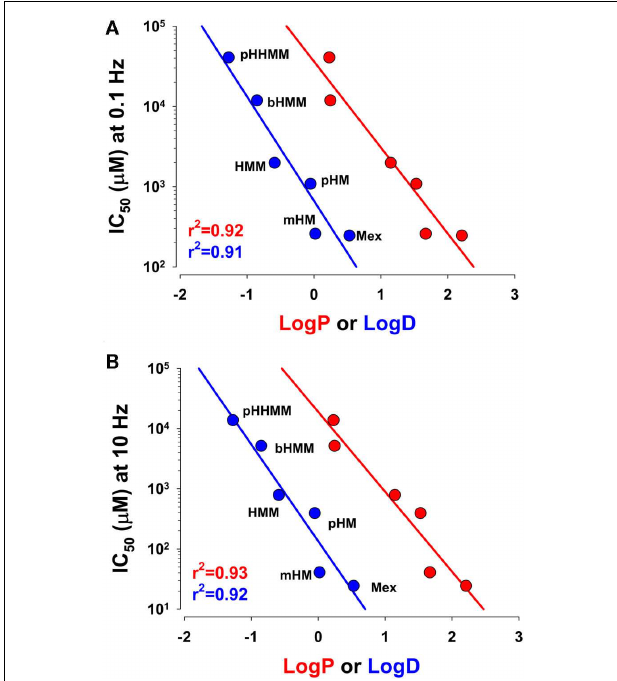
FIGURE 4 | Relationship between IC 50 values for drug action on hNav1.4 channels and drug lipophilicity expressed either as Log P or Log D . The IC 50 values were determined at the holding potential of − 120mV at 0.1Hz (A) or 10Hz (B) stimulation frequency, as described in Figure 3 .The Log P and Log D values were measured as described in Table 1 .The points were linearly correlated with r 2 > 0.9.